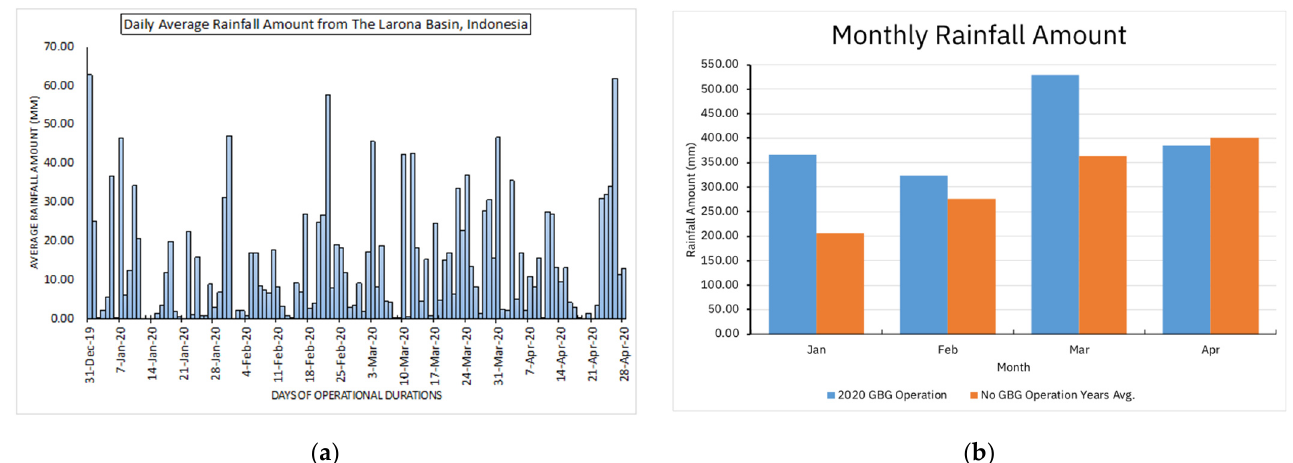
Figure 7. ( a ) The daily average rainfall amounts in the Larona Basin, Sulawesi, Indonesia. ( b ) Monthly rainfall amount during GBG operation days (blue column) and climatological monthly rainfall amount during years without GBG operation (orange column). Non-GBG operation years were 2010–2015 and